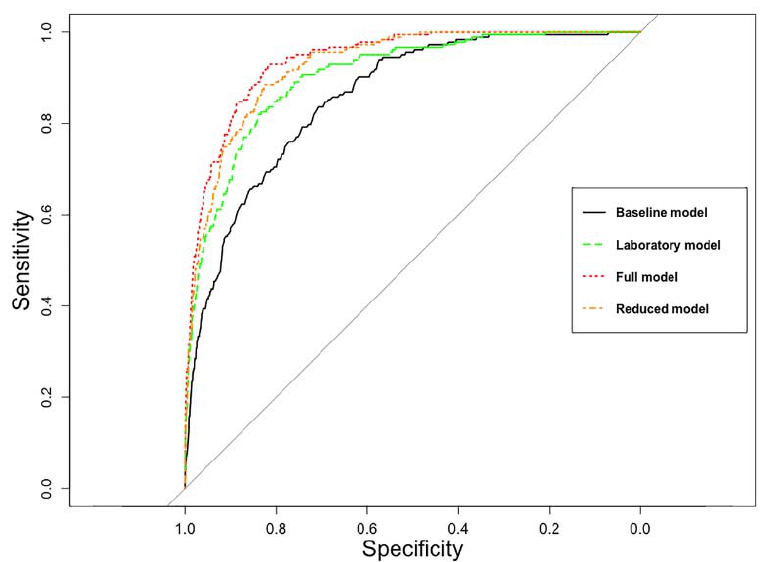
Figure 2. Comparison of the four multivariable logistic regression models regarding probability of in-hospital mortality. The area under the curve was 0.86 (95% CI 0.83–0.88) for the baseline model, 0.90 (95% CI 0.88–0.92) for the laboratory model, 0.94 (95% CI 0.93–0.95) for the full model, and 0.93 (95% CI 0.91–0.94) for the reduced model.